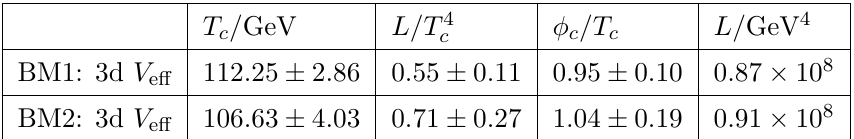
Table 6. Results in 3d perturbation theory with the renormalization scale of dimensional reduction varied from 0 : 5 (cid:25)T to 1 : 5 (cid:25)T , and the 3d scale varied from 0 : 5 T to 2 T as in table 5. For corresponding scale uncertainties, we show the most pessimistic values in the error